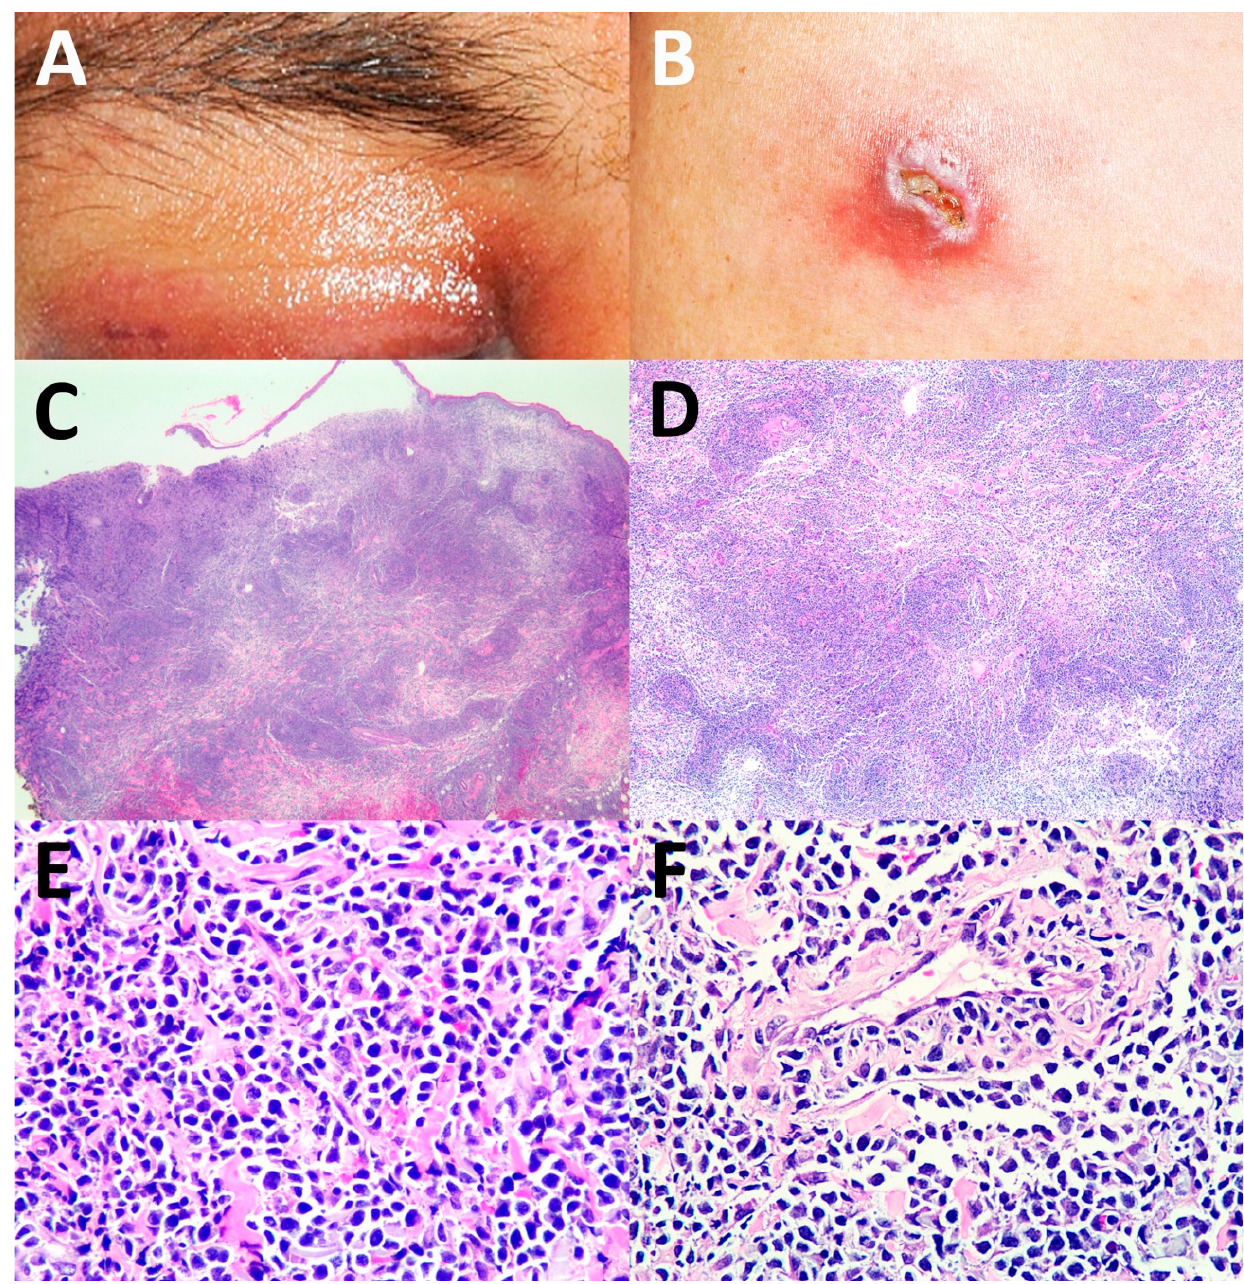
Figure 1. Dermal nodular infiltration pattern: ( A ) cellulitis-like lesion at the periorbital area; ( B ) abscess-like lesion of the skin; ( C – E ) dermal diffuse infiltration by atypical small to medium lymphoid cells (hematoxylin and eosin (H&E), original magnification ×40, ×100, ×400, respectively); ( F ) angioinvasion by atypical lymphoid cells (H&E, original magnification ×400).